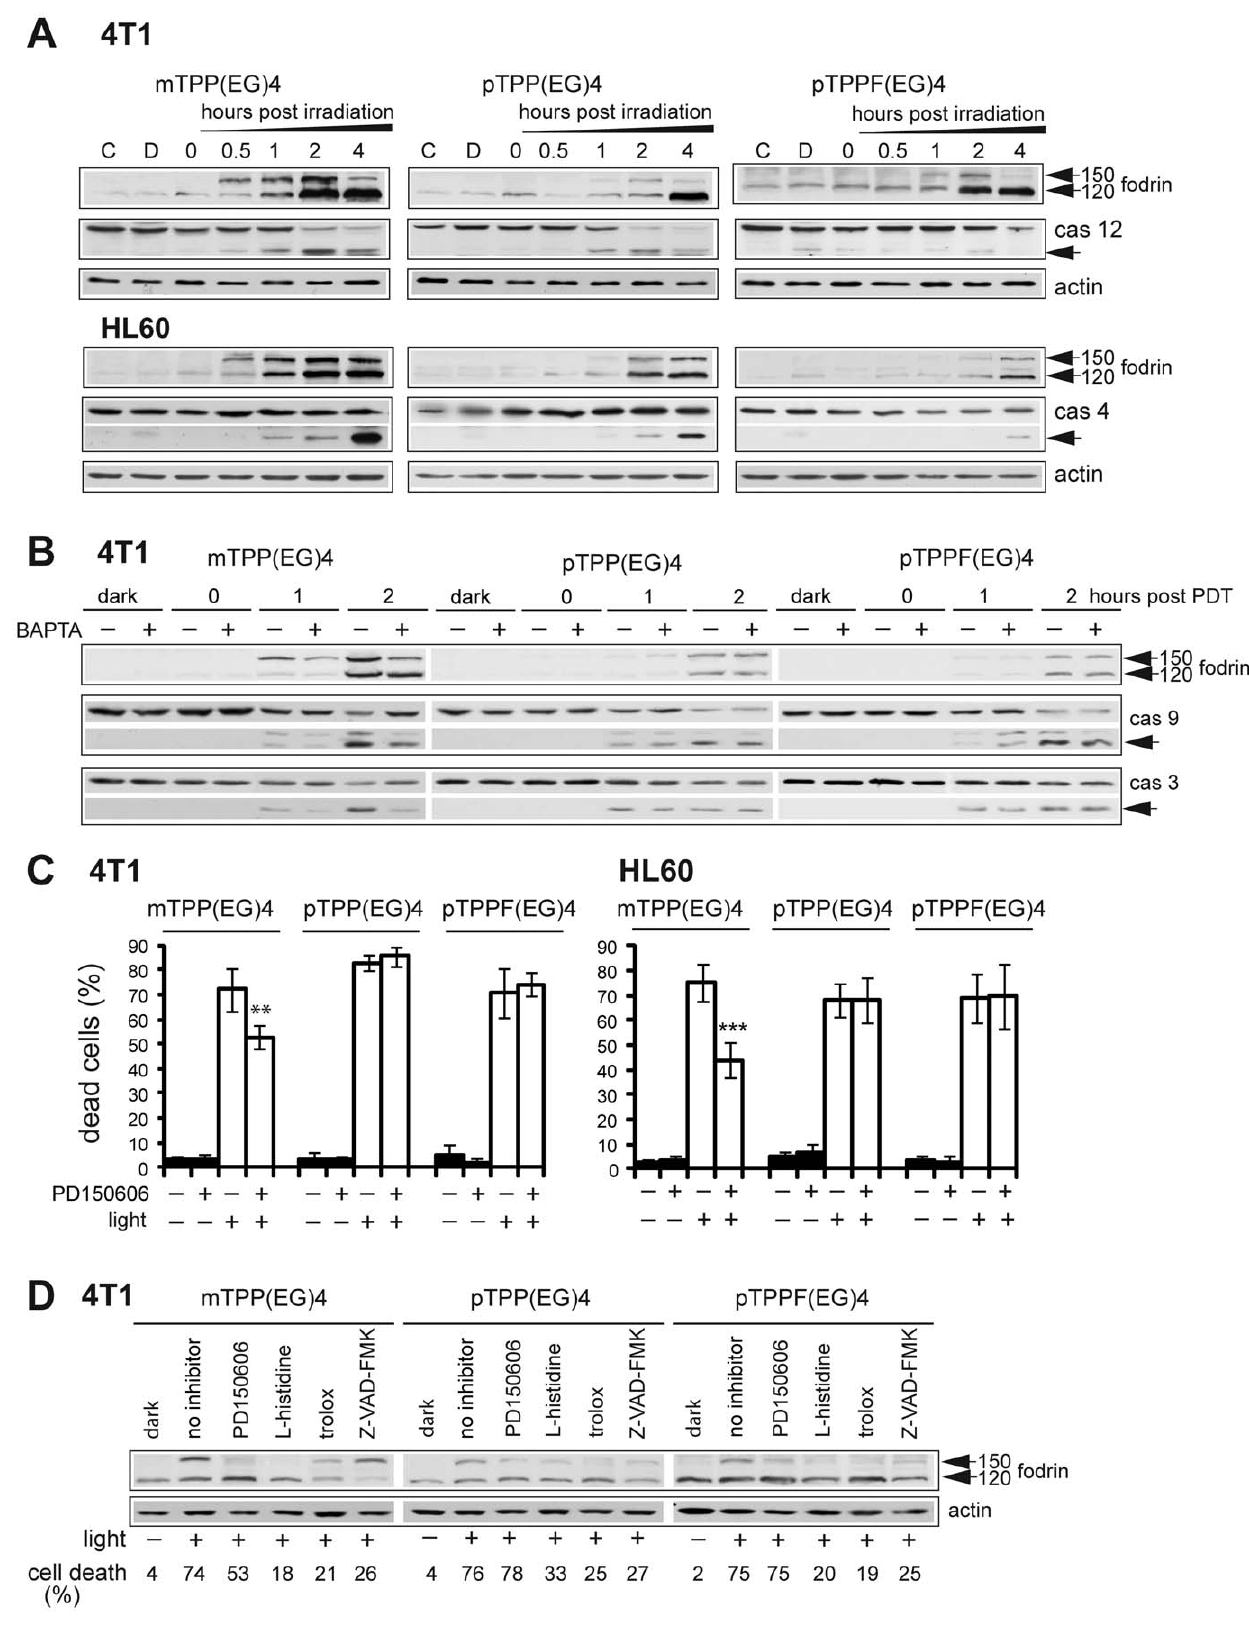
Figure 6. Effect of EG-porphyrin derivatives on Ca 2 + signaling pathway. ( A ) Western blot analysis of fodrin, caspase-12 (4T1 cells) and caspase-4 (HL60 cells). Cells treated with EG-porphyrin derivatives were harvested at various times after irradiation and subjected to Western blot analysis with antibodies recognizing fodrin and caspase-12. Reprobing with b -actin antibody was used to confirm equal loading. The arrowheads PLoS ONE |